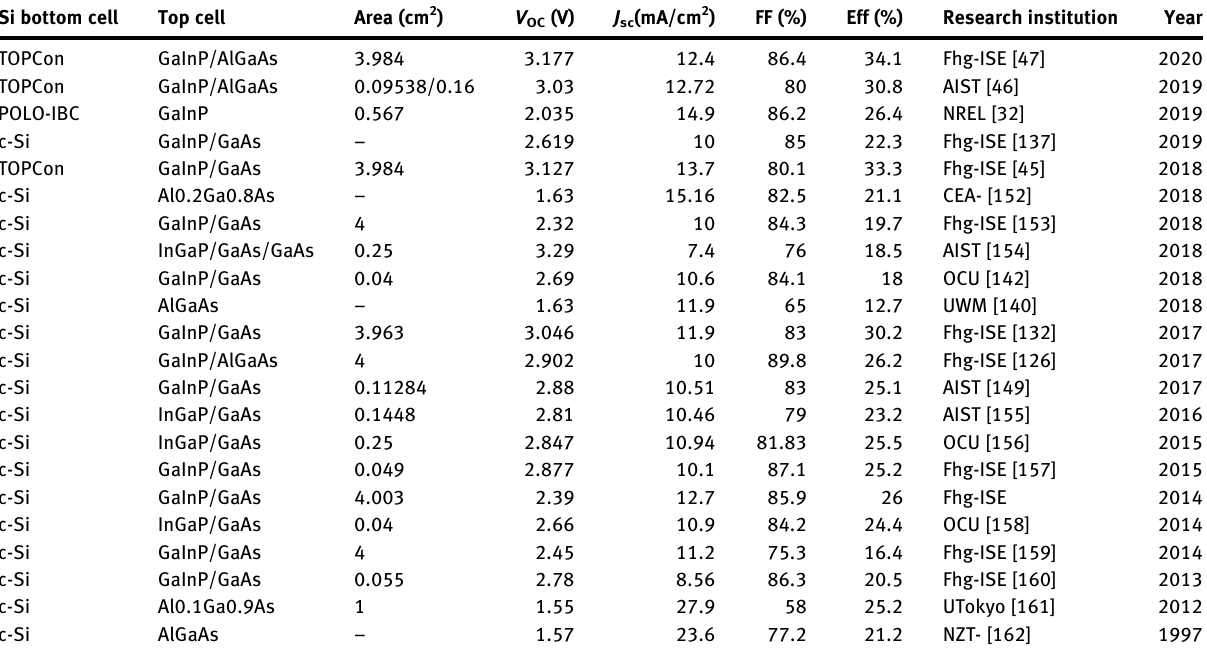
Table  : Summary of the optoelectronic parameters of the  T III – V/Si TSCs. Si bottom cell Top cell Area (cm  ) Textured SHJ